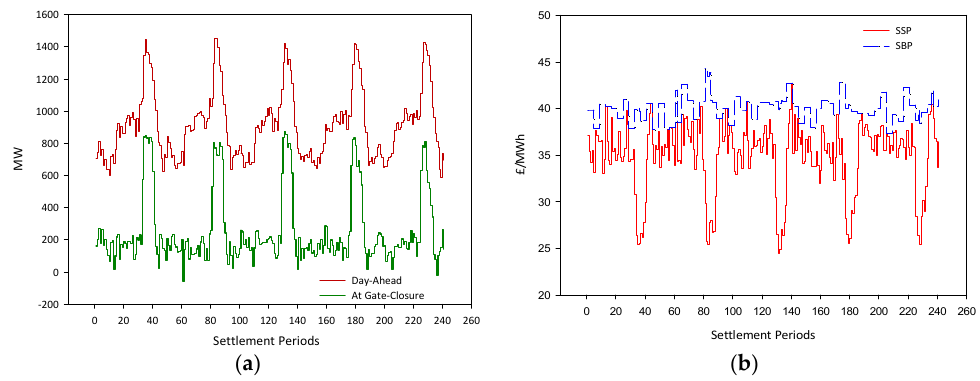
Figure 8. ( a ) System imbalance (IMBAL) at day-ahead and gate-closure positions; and ( b ) the system sell and system buy prices (SSP, SBP) over the corresponding time period. Case1: coal plants = 4, closed cycle gas turbine (CCGT) plants = 7, wind farms = 3.